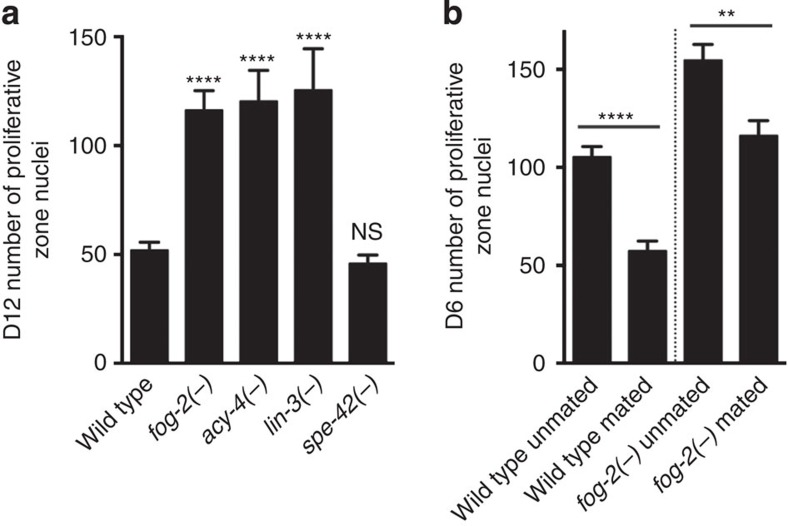
Germ cell flux promotes germline progenitor loss.Average number of proliferative zone nuclei in (a) D12 wild-type, fog-2(−), acy-4(−), lin-3(−) and spe-42(−) animals, (b) D6 wild type and fog-2(−) mutants that are unmated or have been mated with young, wild-type adult males since D4. Error bar indicates s.e.m.; NS, P>0.05; **P<0.01; ****P<0.0001 by two-tailed Student's t-test. Alleles used are as follows: fog-2(oz40), acy-4(ok1806), lin-3(n1058) and spe-42(tn1231). See Supplementary Table 3 for complete genotypes and data.